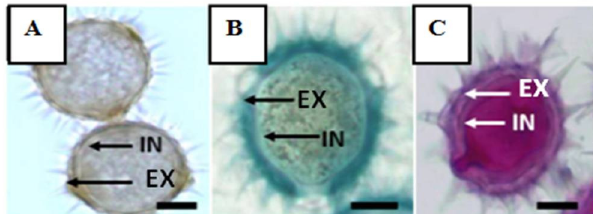
Fig. 7. Pollen grains stained with hematoksilin (A); Coomassie brilliant blue (B); PAS (C); IN: Intine, EX: Exine. Bar: 10 µm